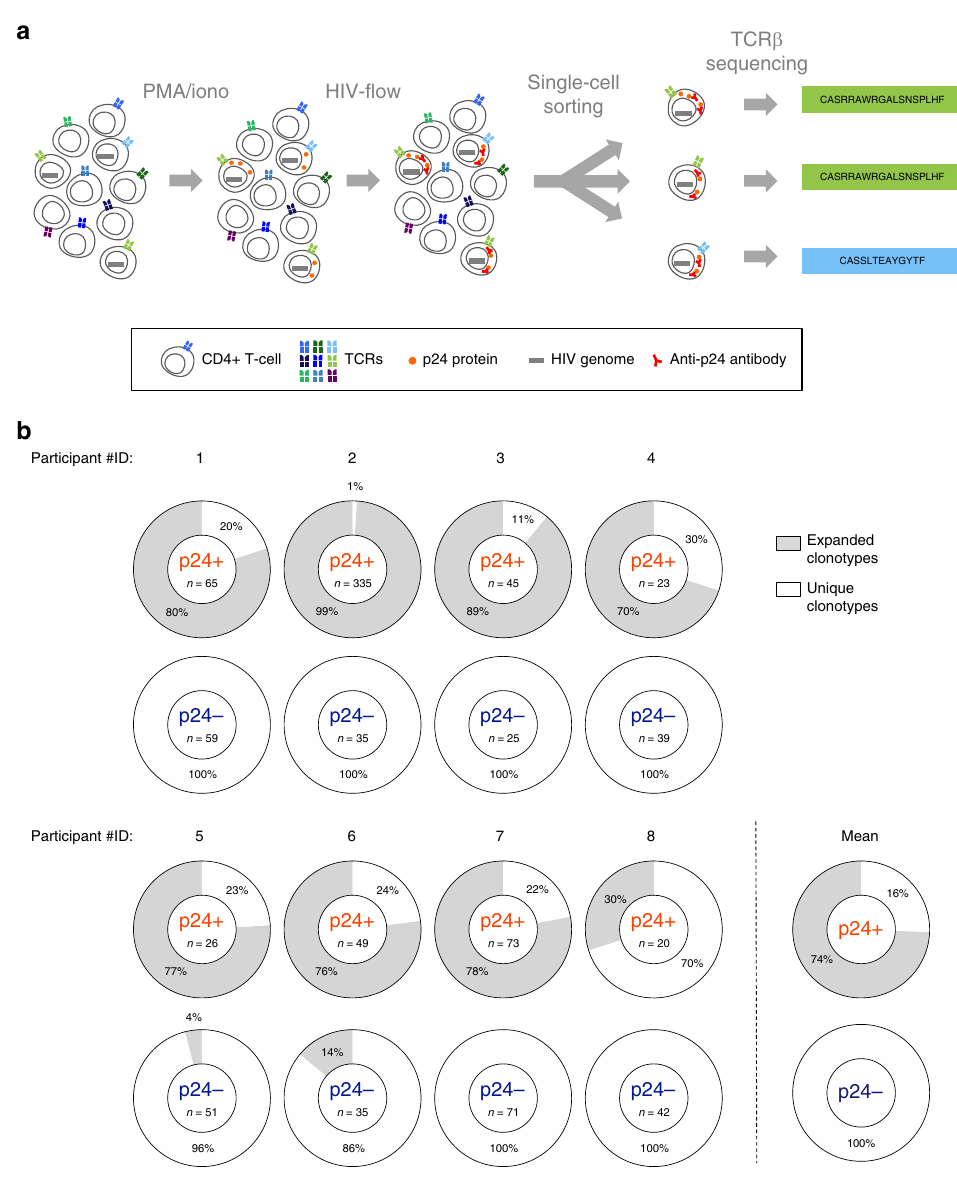
Fig. 1 Experimental strategy for phenotyping and TCR β sequencing of single HIV-infected cells. a Isolated CD4 + T cells were stimulated for 24 h with PMA/ionomycin and single-sorted according to their p24 expression by HIV-Flow. Single sorted p24 + cells underwent a two-round multiplex PCR for ampli fi cation of the V – J junction of the TCR β chain (including CDR3 region) on genomic DNA. CDR3 sequences and V/J-region usage were obtained. b The proportion of clonal expansions (in gray) in the pool of p24 + and p24 − cells is represented as a pie chart for each participant. Pie charts at the bottom right represent the mean proportion of clonal expansion from all participants. Source data are provided as a Source Data fi